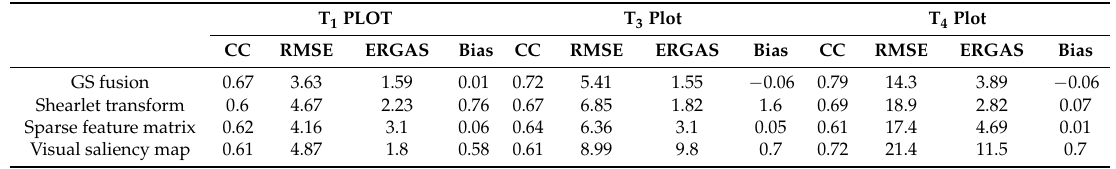
Table 3. Results of image fusion effect evaluation with different fusion methods. Correlation coefficient (CC); Erreur relative globale adimensionnelle de synthese (ERGAS); Root mean square error (RMSE). T 1 PLOT T 3 Plot T 4 Plot CC RMSE ERGAS Bias CC RMSE ERGAS Bias ERGAS